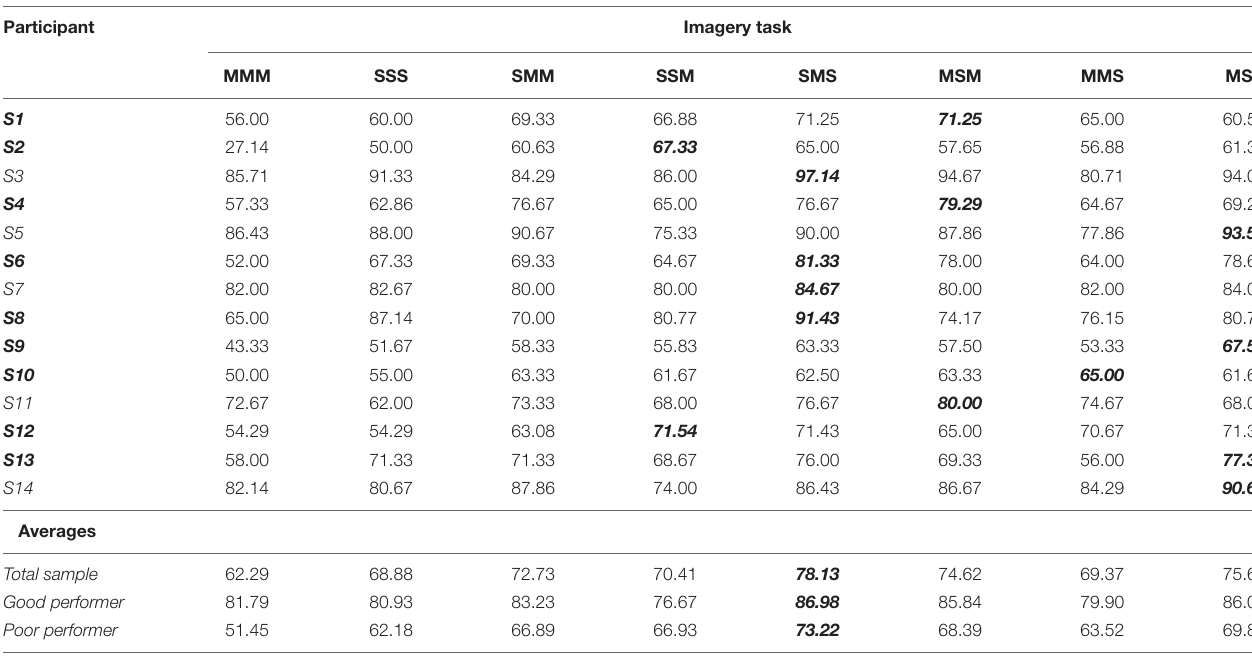
TABLE 2 | Classification accuracy of imagery tasks under cross-modality